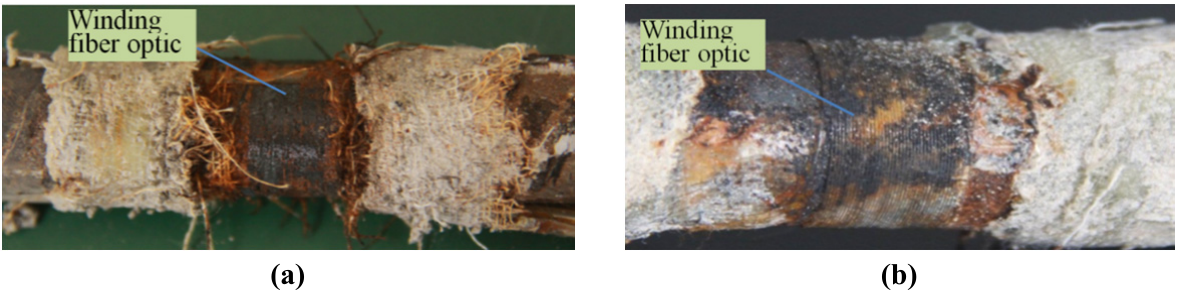
Figure 17. (a) The steel corrosion of S.1 (I) in the specimen No. 1; (b) The steel corrosion of S.2 (I) in the specimen No.